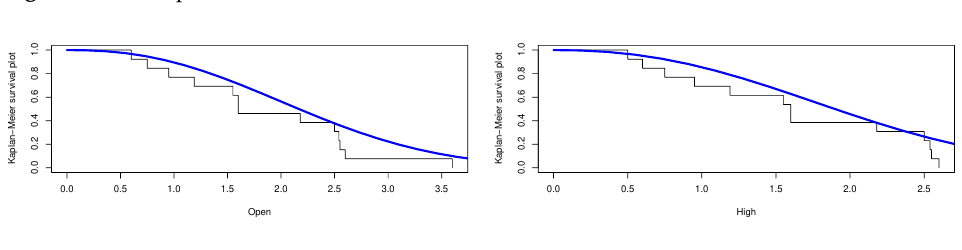
Figure 6. The PP plot of the E-WD.